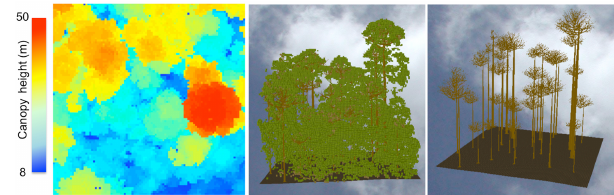
Figure 1. DART model scene of an Amazon forest (50m × 50m): (a) nadir view of canopy height, (b) oblique view of 1m 3 leaf voxels and woody architecture, and (c) tree objects for canopy tree crowns and